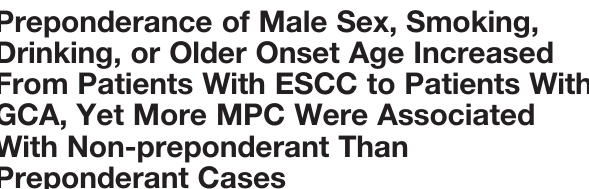
without between both males (49.8 ± 5.1 vs. 53.6 ± 8.2 years old, P =0.038) and females (45.9 ± 3.8 vs. 53.6 ± 6.6 years old, P =0.001) ( Table 2 ).